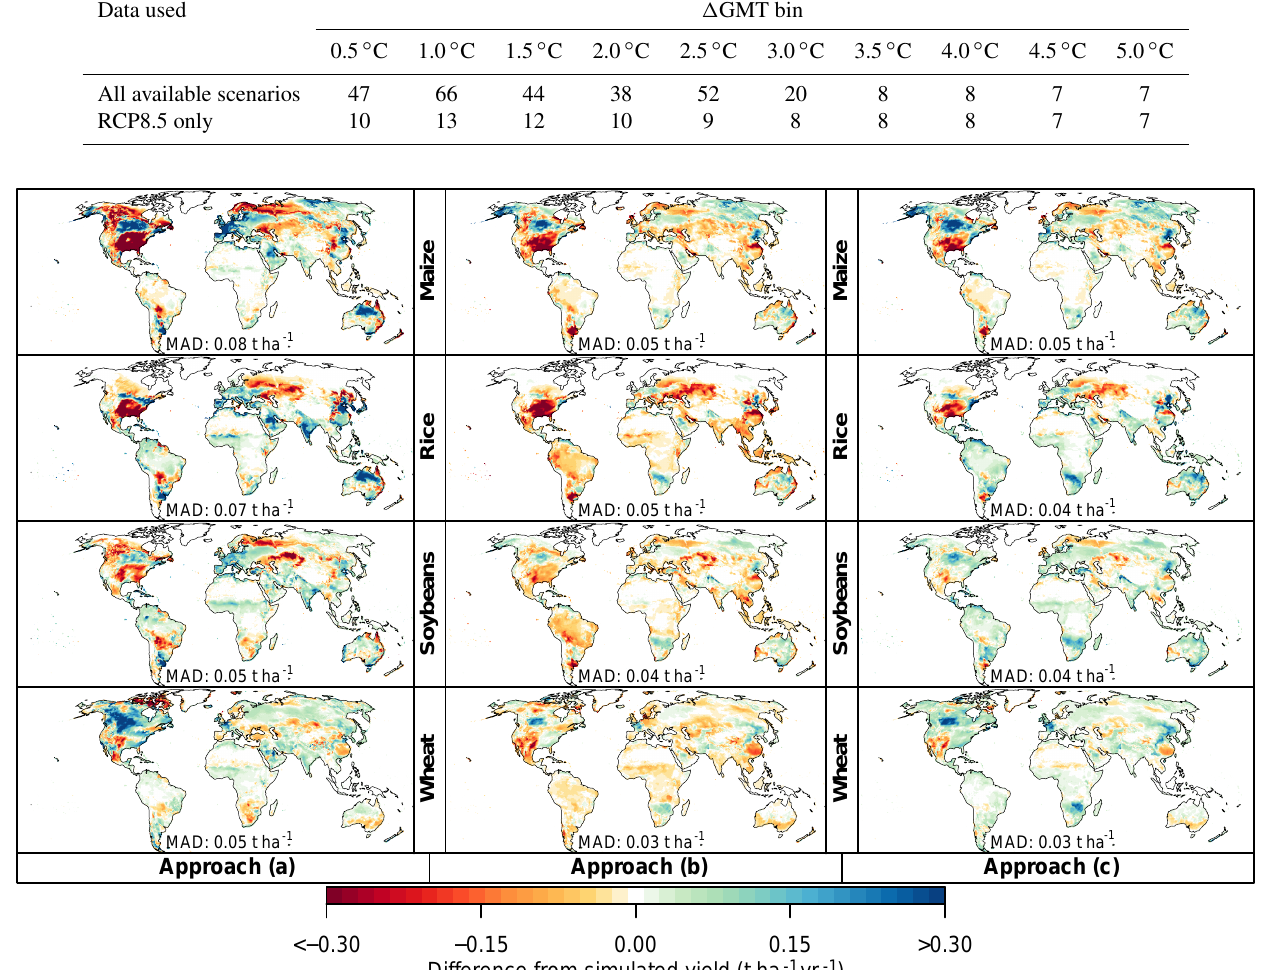
Figure 8. Validation of the three emulator approaches. Maps show the difference (emulated minus simulated) among the simulated LPJmL yields forced by HadGEM2-ES climate for RCP4.5 under rain-fed conditions, averaged over all years falling into the (cid:49) GMT bin of 2.5 ◦ C (2066–2094), and the emulated yields for the same years based on approach (a) (left column panels), approach (b) (middle column panels), and approach (c) (right column panels). Rows: different crops. MAD: mean absolute difference, regardless of sign, averaged across all grid points. Analogous figures for irrigated conditions and for different GGCMs are available in the